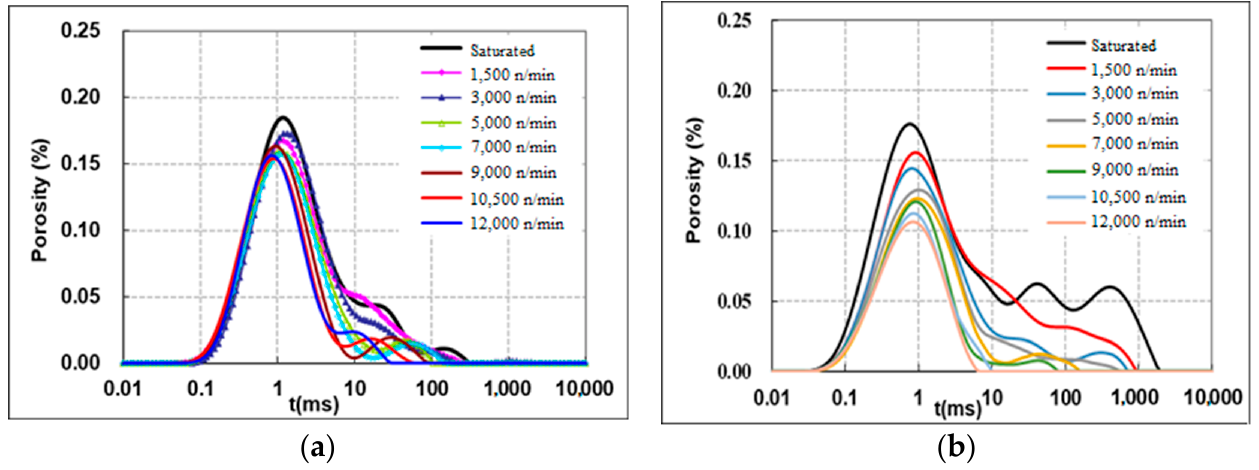
Figure 1. NMR T 2 spectrum curves at different rotational speeds: ( a ) before fracture; ( b ) after frac- ture.